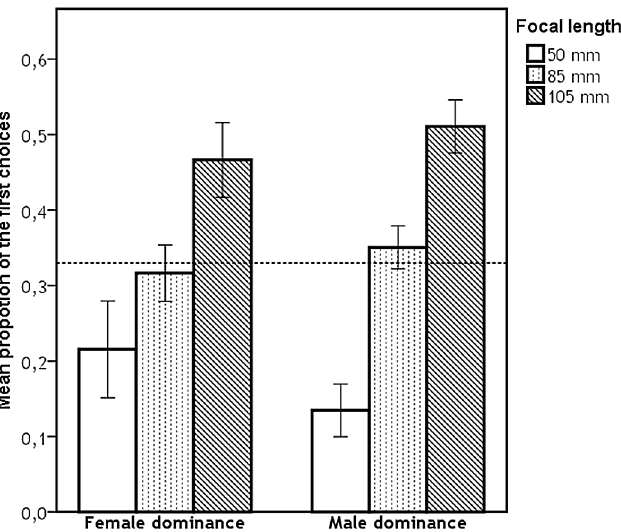
Fig 3. Proportion of first choices for each focal length with respect to their dominance. Dashed line represents the proportion of ratings expected by chance (i.e., 0.333), error bars represent 95% CI.